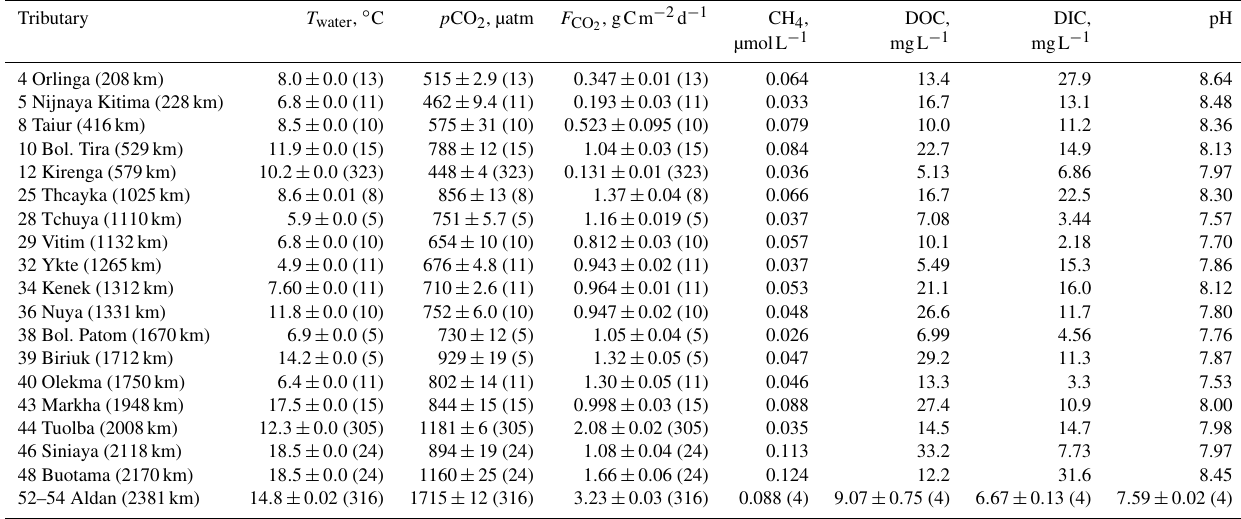
Table 2. Measured water temperature, p CO 2 , calculated CO 2 flux, CH 4 , DOC, DIC concentration, and pH in the tributaries (average ± SD; ( n ) is number of